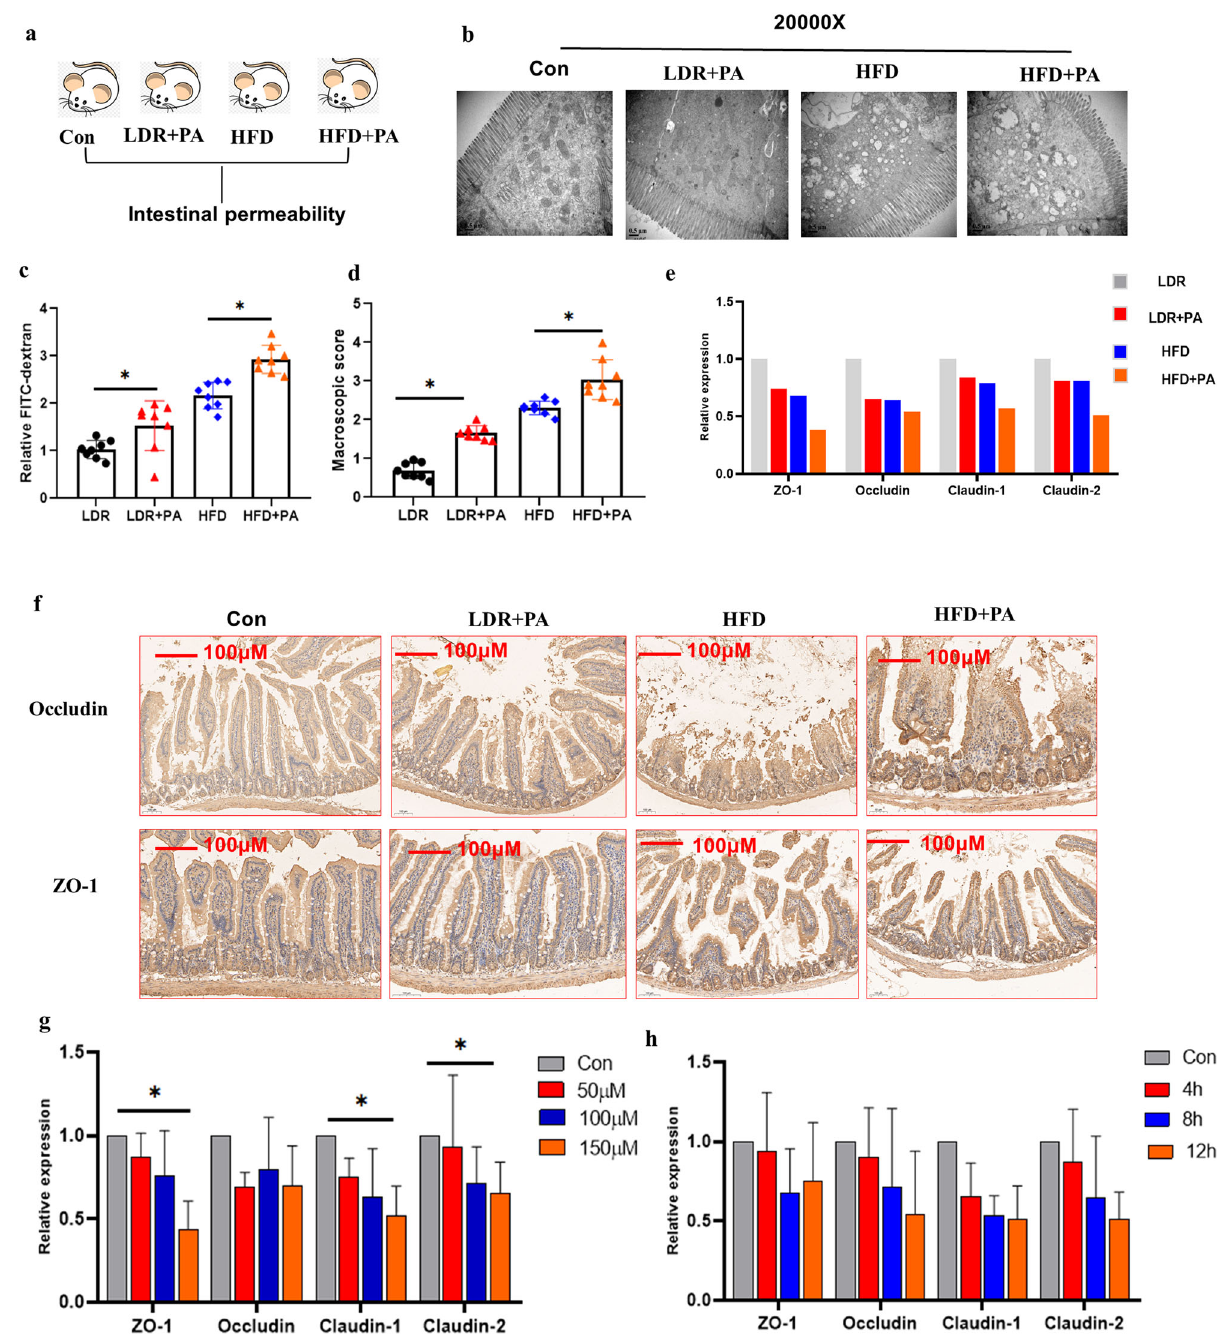
Fig. 6 PA promotes HFD-induced intestinal impairments. Mice were divided into four groups: the Con, LDR (0.05 Gy*10) + PA, HFD, and HFD + PA groups. a Trial design for exploration of the effects of PA on mice. b Representative electron microscopy images of intestinal structure among the four groups. 20000X. c Relative FITC-dextran levels. d Macroscopic scores. e mRNA expression of the intestinal tight junction genesZO-1, Occludin, Claudin-1 and Claudin-2 among the four groups. f Immunohistochemical detection of Occludin and ZO-1 in intestinal tissues. Scale bar: 100 µ m. g The HCT116 cell line was used to detect theeffects of PA on intestinal tight junction gene mRNA expression at the indicated PA concentrations. h The HCT116 cell line was used to detect the effects of PA on intestinal tight junction gene mRNA expression at the indicated PA treatment timepoints. The data are the means± SDs. The Mann-Whitney test or two-tailed unpaired Student ’ s t -test was used for statistical analyses. * p < 0.05 indicates a signi fi cant difference. Error bars indicate SEM (standard error of the mean). a was created by Ruixue Huang and the elements used was permitted by Biorender (https://biorender.com/) because Ruixue Huang is one of the registered